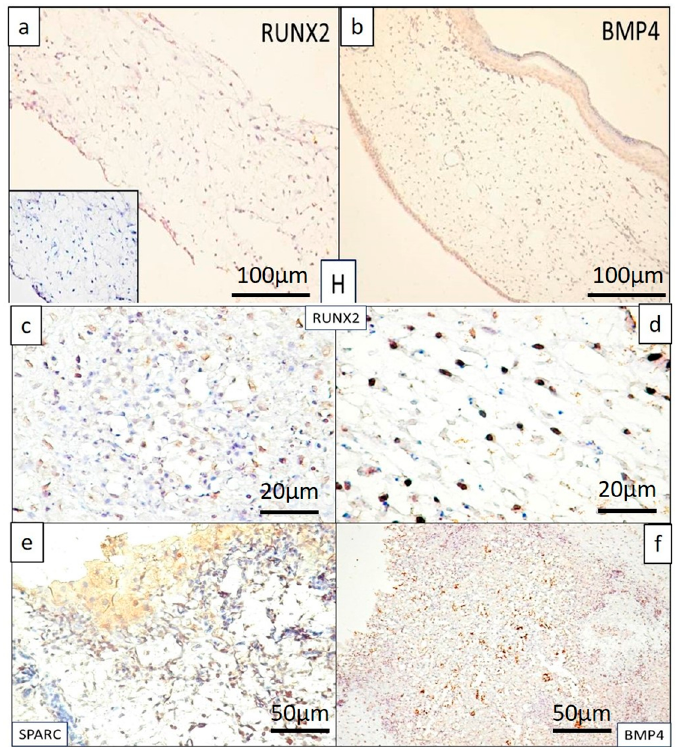
Figure 3. RUNX2 ( a ) and BMP4 ( b ) in hyaluronic acid (H) treated CAM specimens were negative. RUNX2 with moderate and heterogeneous expression in the BSH implant ( c ) and the implant adjacent to the CAM stroma ( d ). Moderate reaction for SPARC with an intense positive reaction in endothelial cells associated with inflammation adjacent to the implant ( e ). BMP4 is strongly positive in the vessels that invaded the BSH implant, but absent in the resuspended cells ( f ).